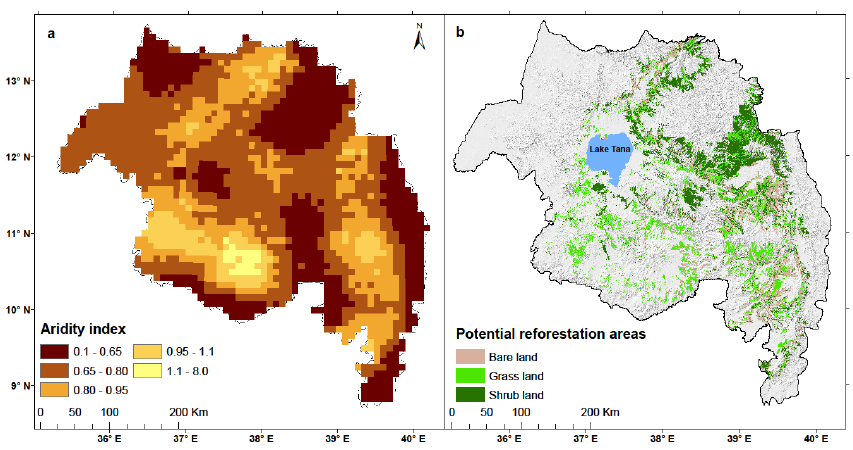
Figure 2. ( a ) Aridity index and ( b ) potential reforestation area in the Amhara Region. Climate data (0.083° resolution) for deriving the Aridity index came from Sisay et al. [48].